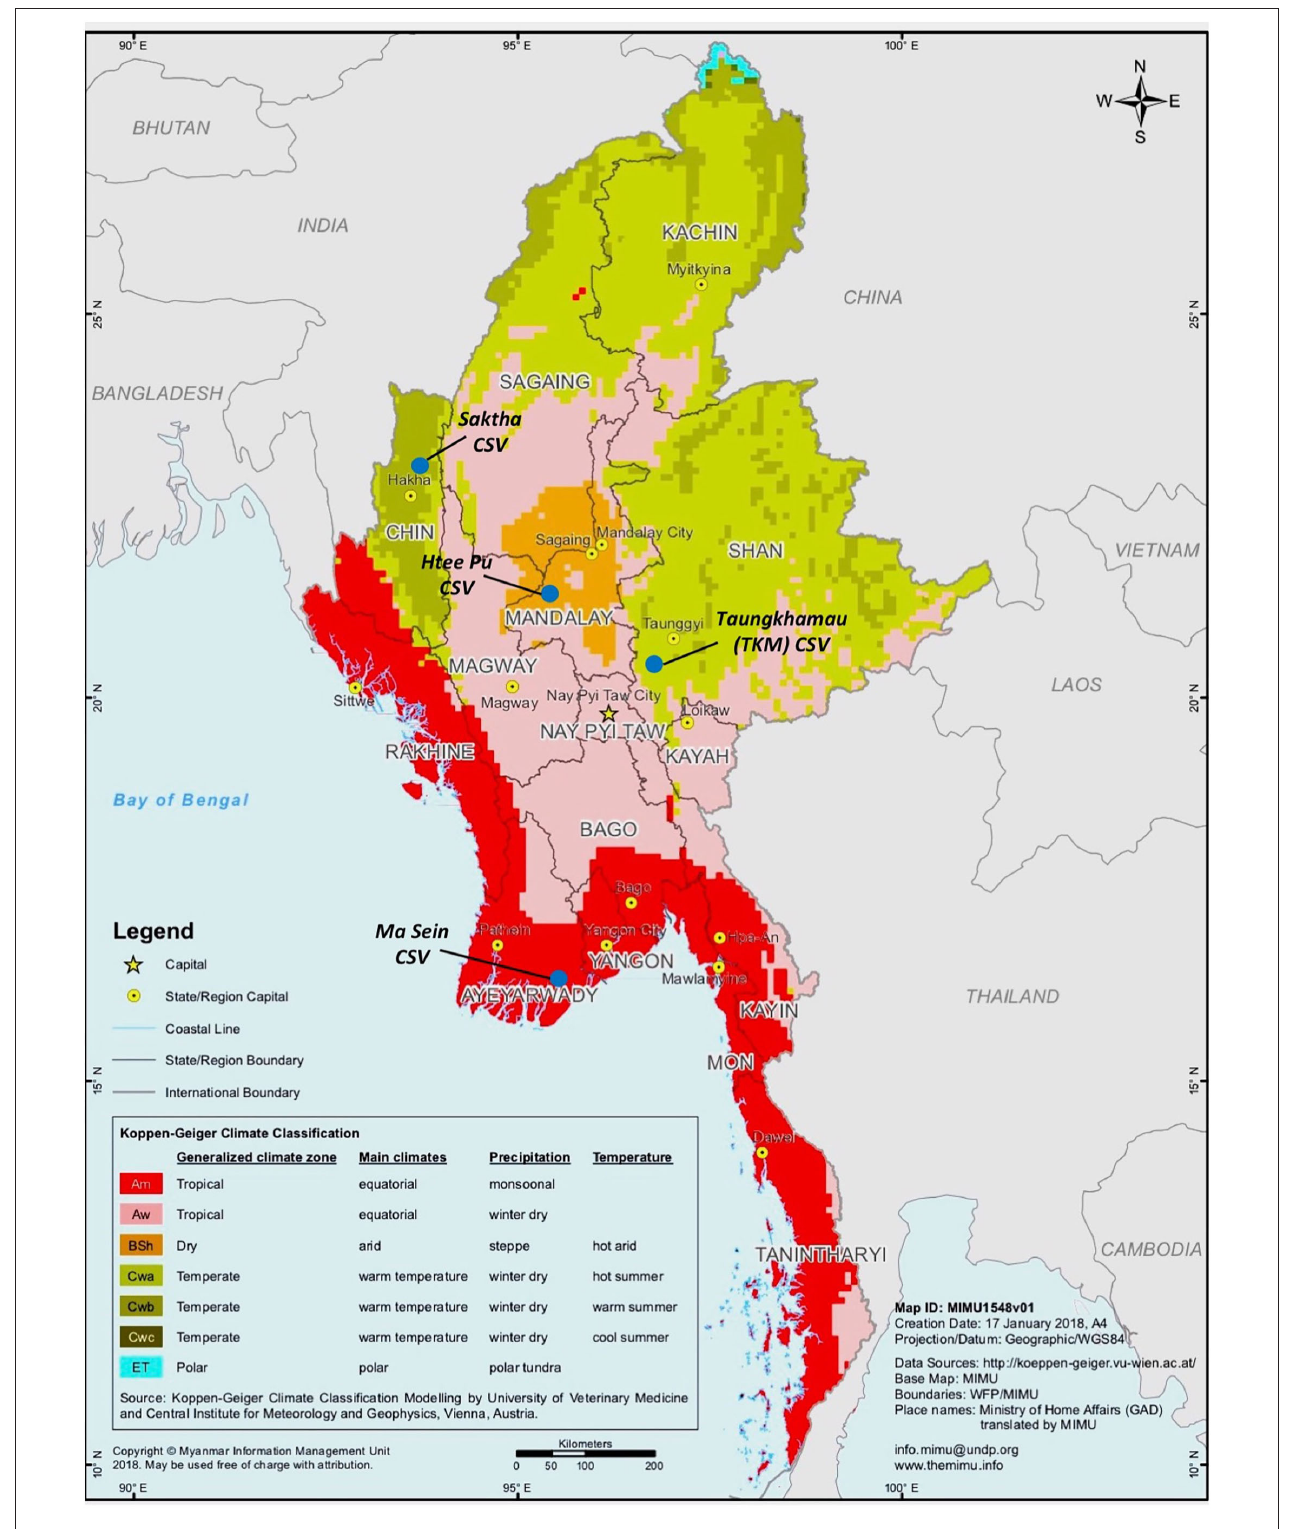
FIGURE 1 | Location of the Myanmar CSVs. [Map Source: Myanmar Information Management Unit, 2018].